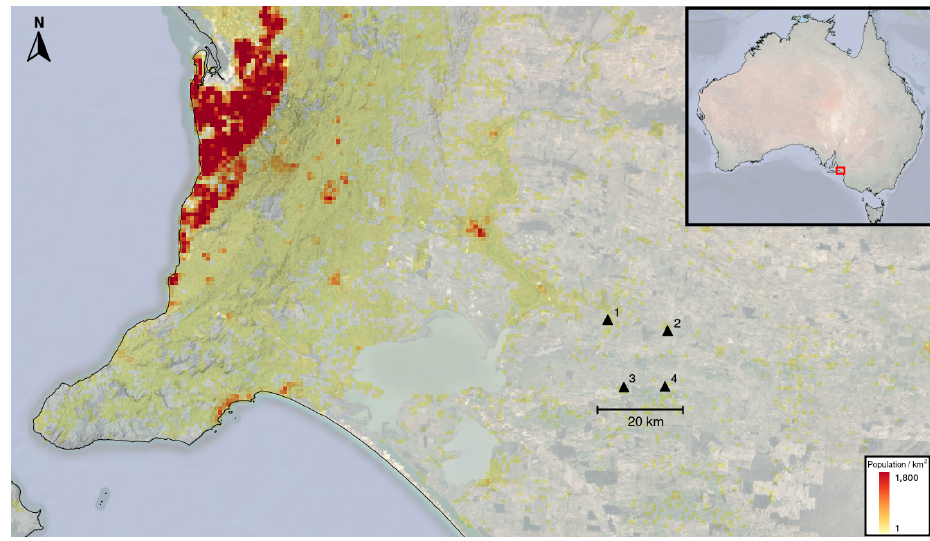
Figure 4. Location of the 4 sites where the Geodes were tested. Each site consisted of a buried Geode with a collocated Nuseis node. The sites were all situated in an area with low population density.